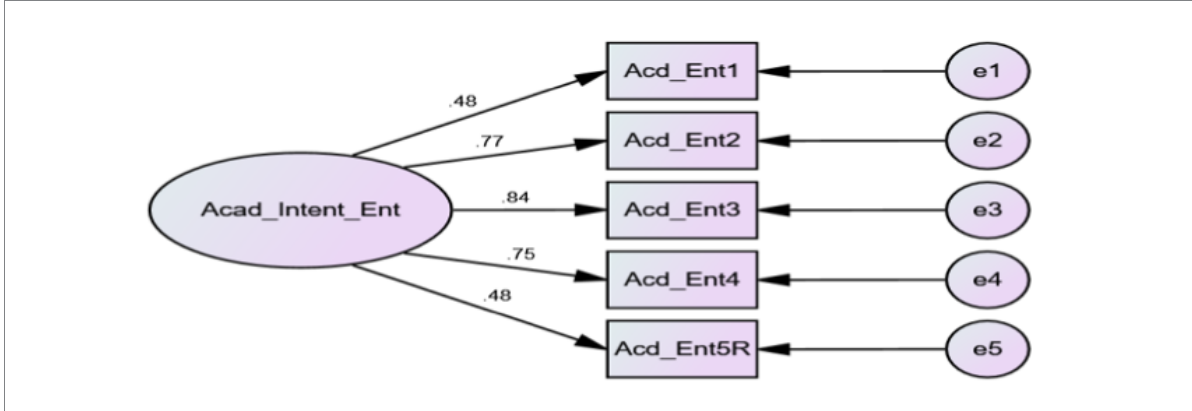
FIGURE 1 Confirmatory factor analysis (CFA) for brief measure of perceived academic intent to